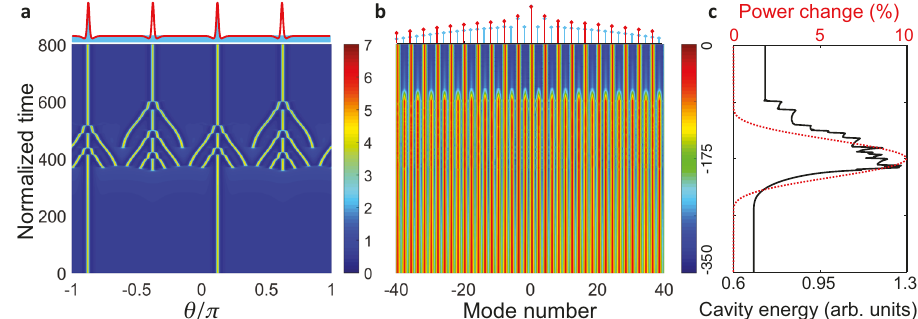
Fig. 4 Melting of a discrete time crystal (DTC). Convergence and merging of solitons with strong pump power disruptions. The evolution of the pulse train ( a ) and its spectrum ( b ) in the cavity show that the initial state consisted of 2 solitons per round-trip time (a 2-DTC, ω M = 4 D 1 ). The power change pro fi le (red dotted curve) and intra-cavity energy (black solid) are plotted in c . Power change increases the intra-cavity energy and more solitons form, all converging to the stable equilibria enforced by the pump modulation ( M = 4). The fi nal state constitutes 4 solitons per round-trip time, one in each potential minimum. The initial (bright blue) and fi nal (red) waveforms and comb spectra are depicted on top in a and b . Parameter values are the same as those in Fig.